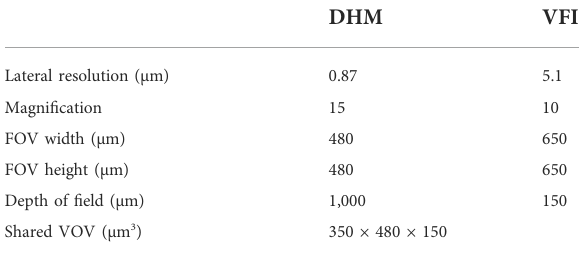
TABLE 1 DHM and VFI performance speci fi cations.